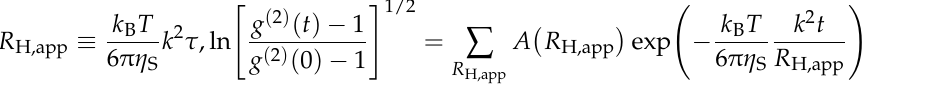
Table 1. Refractive index increments ∂ n/ ∂ c and small-angle X-ray scattering (SAXS) contrast factors γ of PFSI in water–methanol (MeOH) mixtures with different w H w H 2